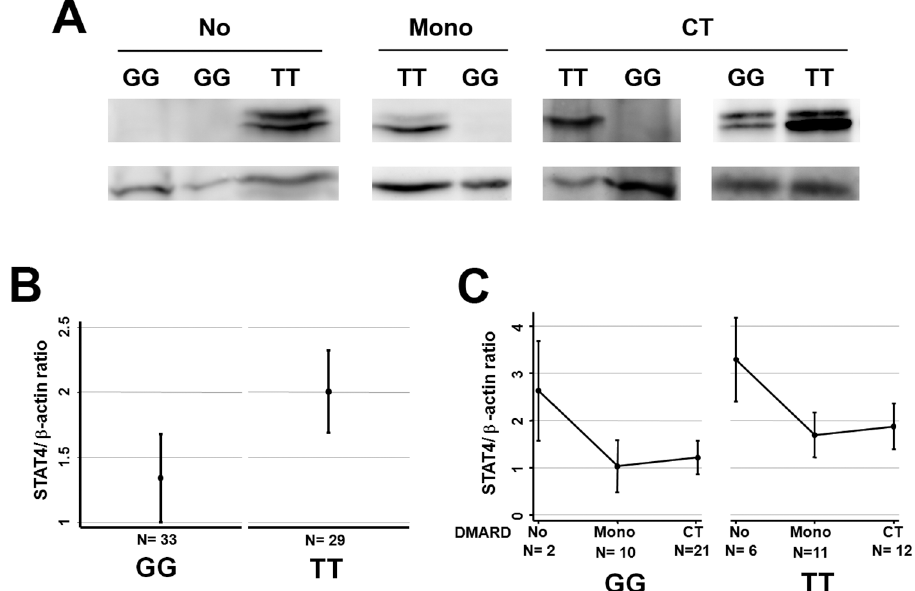
Fig 3. STAT4 protein is increased in patients with early arthritis carrying the TT genotype of rs7574865. A) Western blot analysis of the STAT4 expression in PBMCs from patients with TT or GG rs7574865 genotype with different treatments. Representative blots are shown. B and C) Densitometric quantification of STAT4 protein expression normalized to β -actin expression. The graph represents the linear prediction with 95% confidence intervals of STAT4/ β -actin ratio according to the multivariable analysis displayed in Table 3 represented by rs7574865 genotype (B) or by DMARD treatment (No DMARD, Monotherapy or Combined Therapy) and rs7574865 genotype